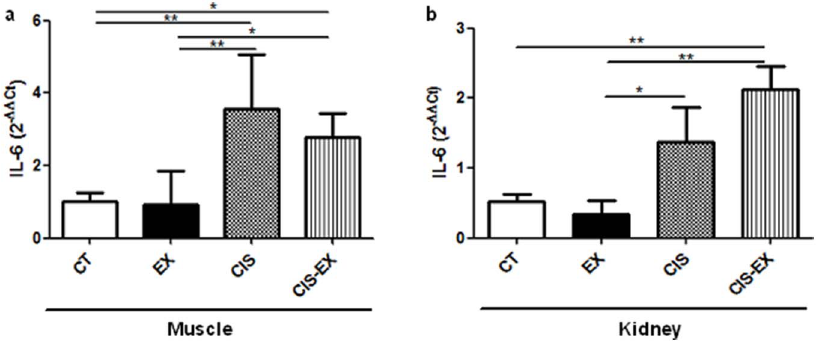
Figure 4. IL-6 contributes to kidney protection induced by exercise. The expression of the cytokine IL-6 was determined by qPCR in the muscle ( A ) and the kidney ( B ). The CIS group showed increased levels of IL-6 in both tissues compared to sedentary groups (CT and EX). However, CIS-EX showed increased IL-6 expression in the kidney, which indicates the protective role of IL-6 in this model. *P , 0.05; **P , 0.01.